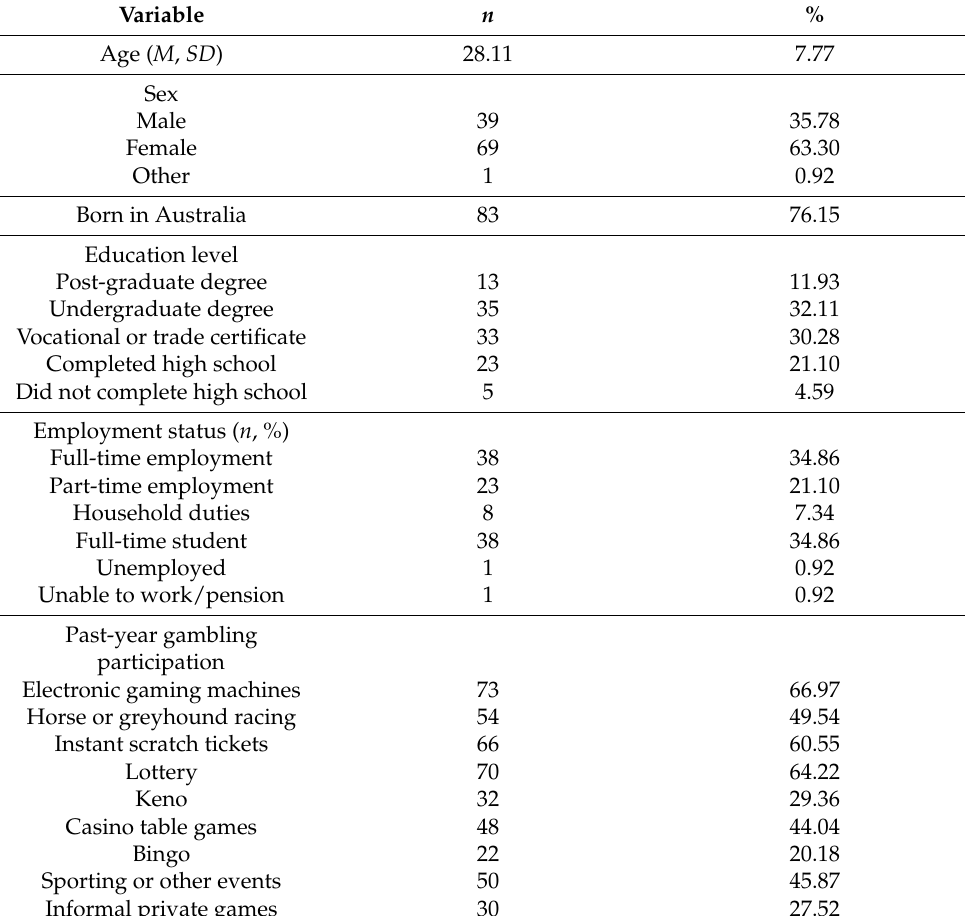
Table 1. Descriptive statistics ( n =